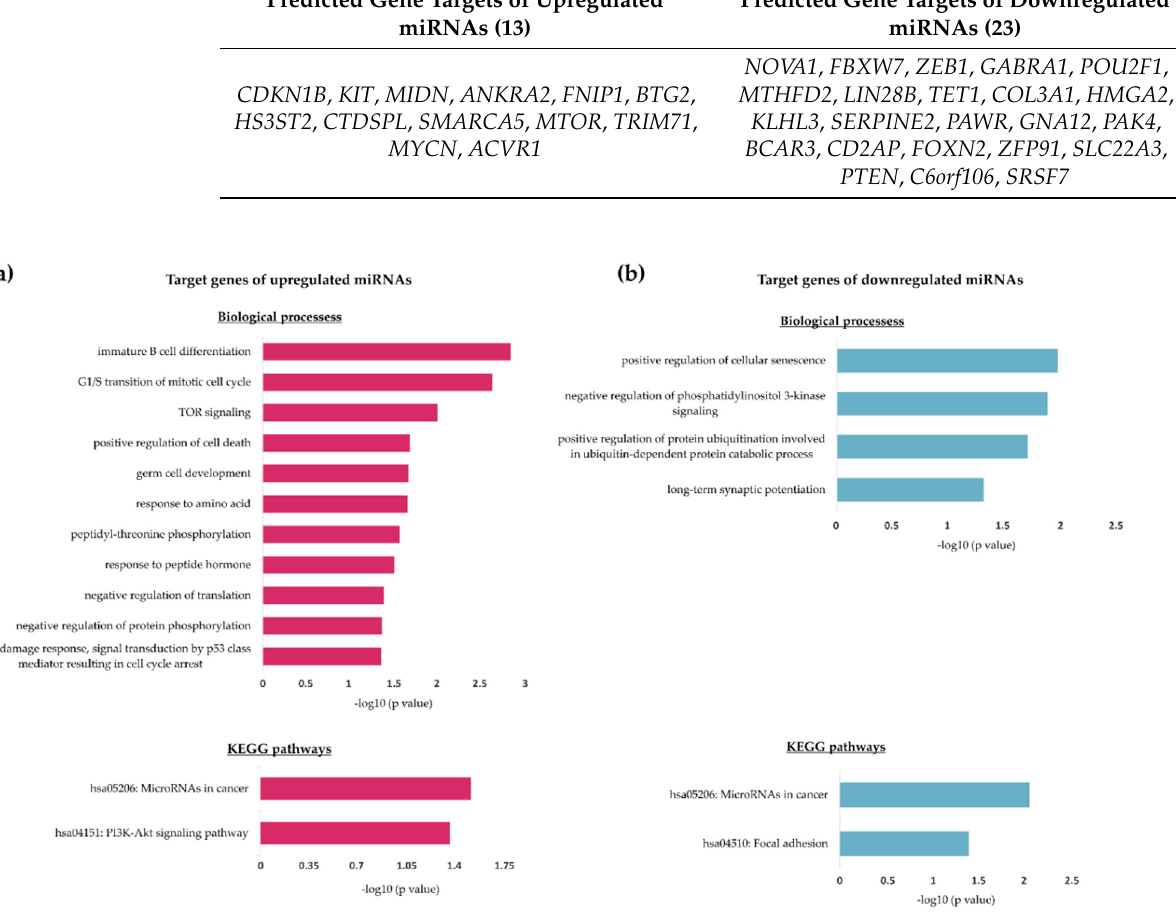
Figure 2. Biological process and KEGG pathway analysis of predicted target genes of differentially expressed miRNAs in Ramos cells exposed to HIV-1 AT-2. Biological processes (upper bar graph) and KEGG pathways (lower bar graph) significantly associated with predicted gene targets of upregulated ( a ) and downregulated ( b ) miRNAs. Data are represented as − log10( p value); only significantly enriched associations were annotated ( p < 0.05).